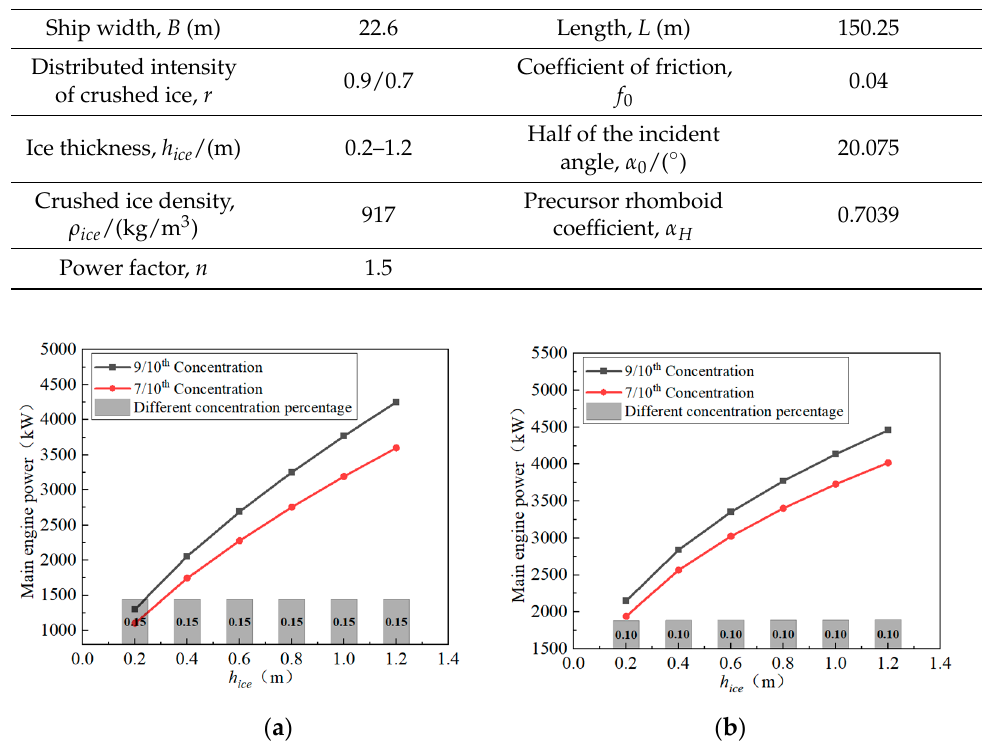
Figure 12. Power calculation with different pack ice concentration. ( a ) Traditional icebreaker bow, ( b ) Semi bow. ( b ) Semi